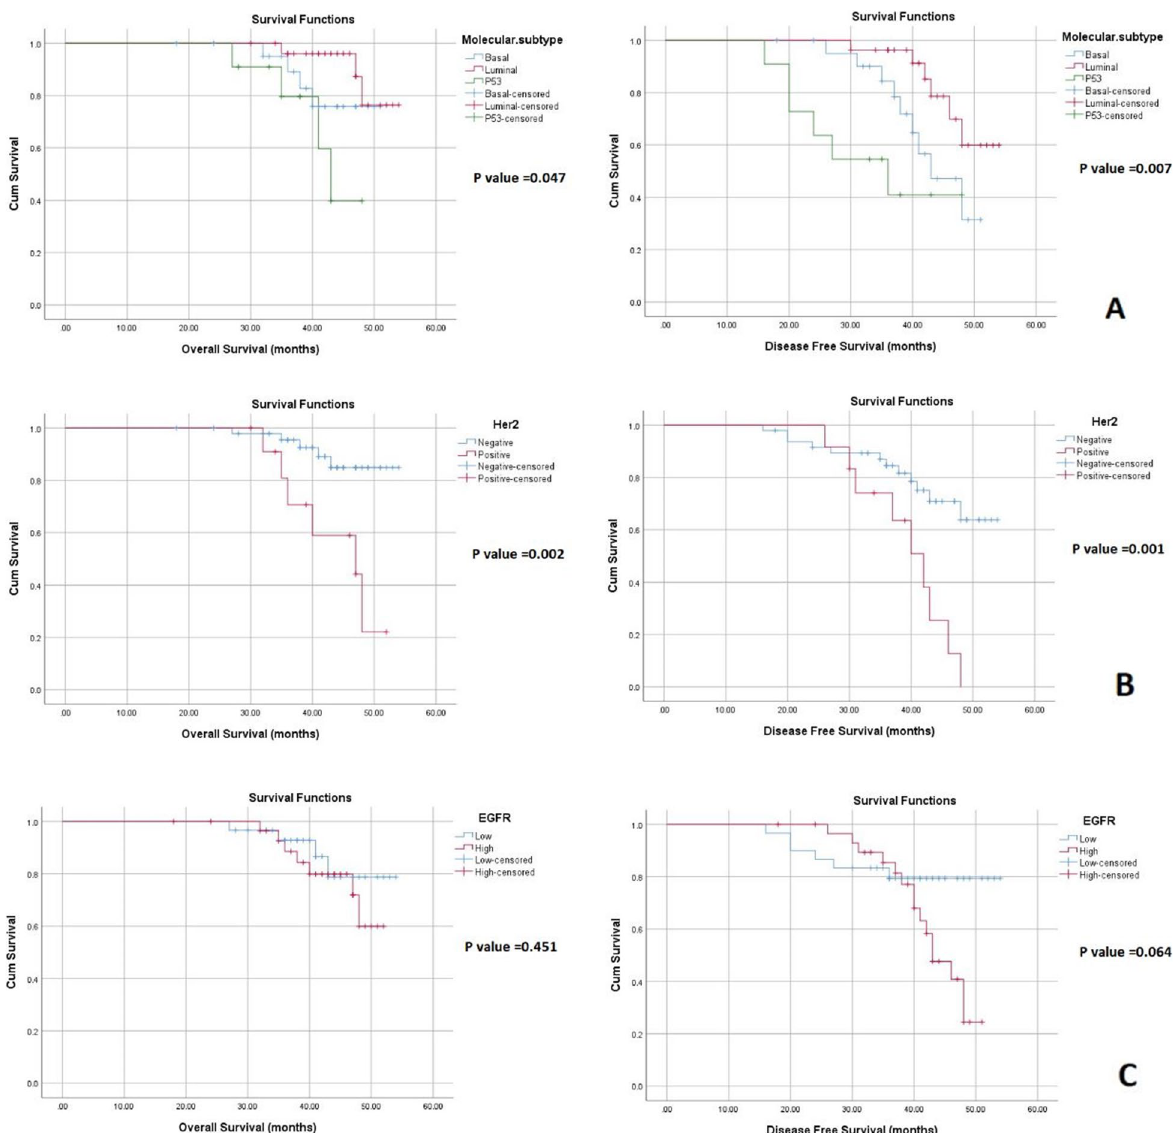
Fig. 6 Kaplan‑Meier survival curve showing. A : The relation between molecular subtypes of MIBC and DFS and OS. B : The relation between HER2 expression in MIBC and DFS and OS. C : The relation between EGFR expression in MIBC and DFS and OS